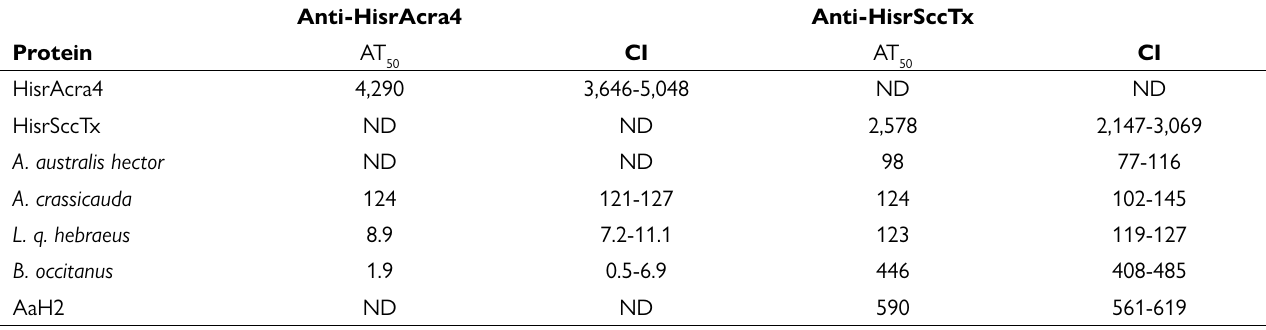
Table 3. Antibodies titers from rabbits versus the recombinant HisrAcra4, HisrSccTx and scorpion venoms